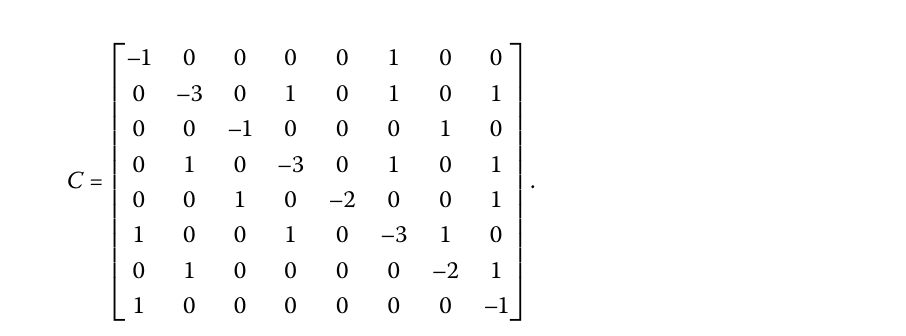
),0.7sin( 2 π ),0.75sin( 2 π )). 15 15 15